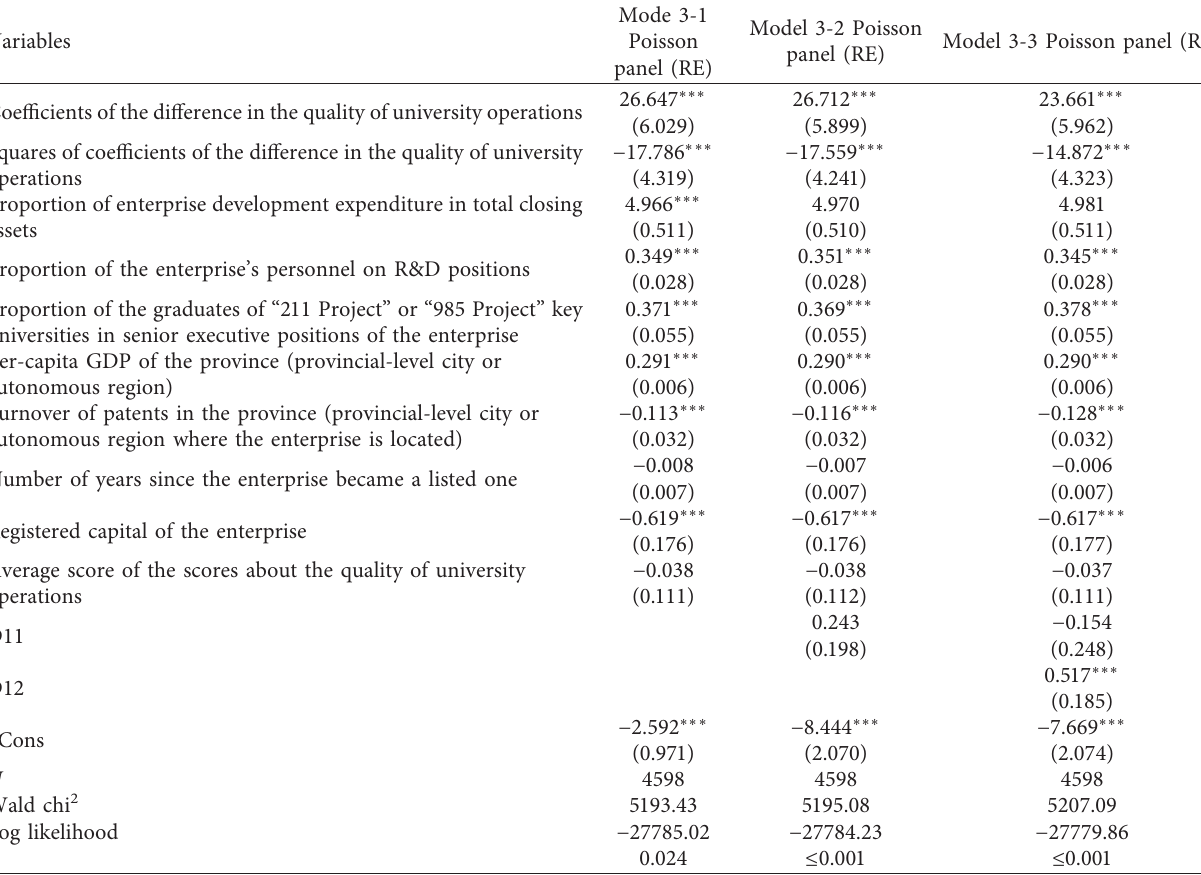
Table 5: Result of the re-estimation of enterprise